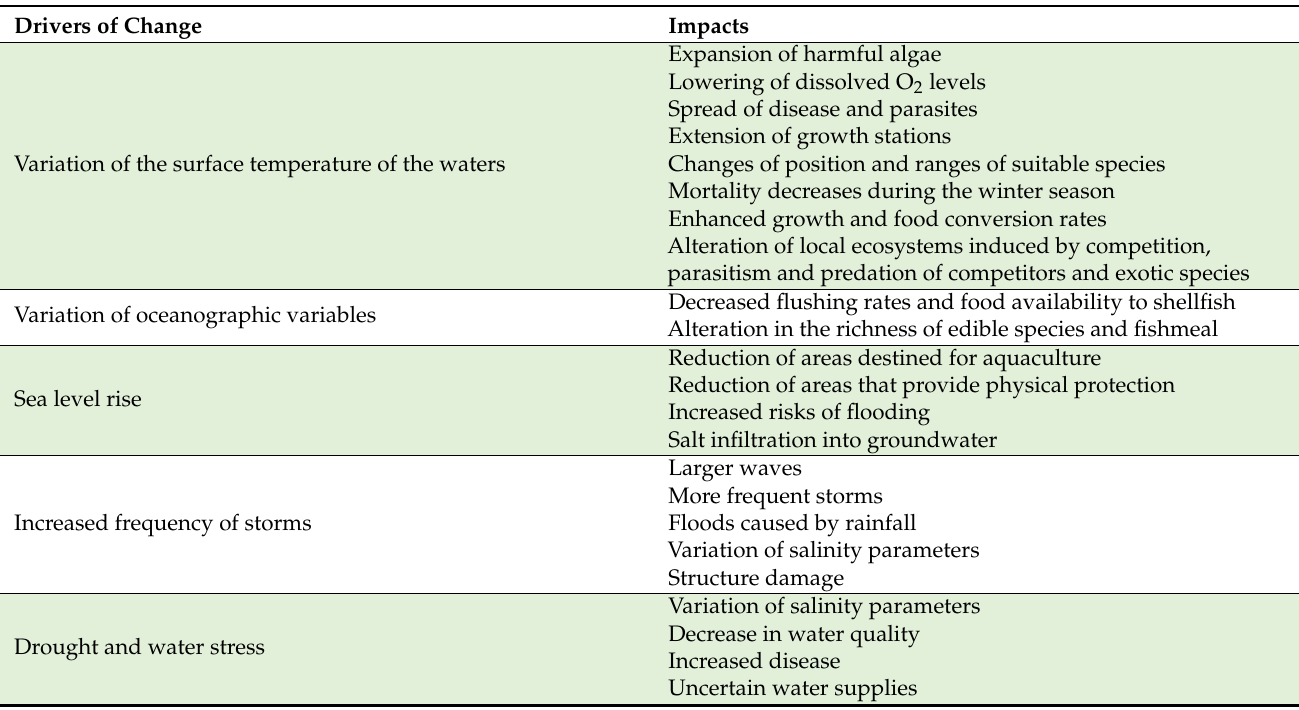
Table 1. Potential impacts of climate change on fisheries and aquaculture (adapted from Barange and Perry